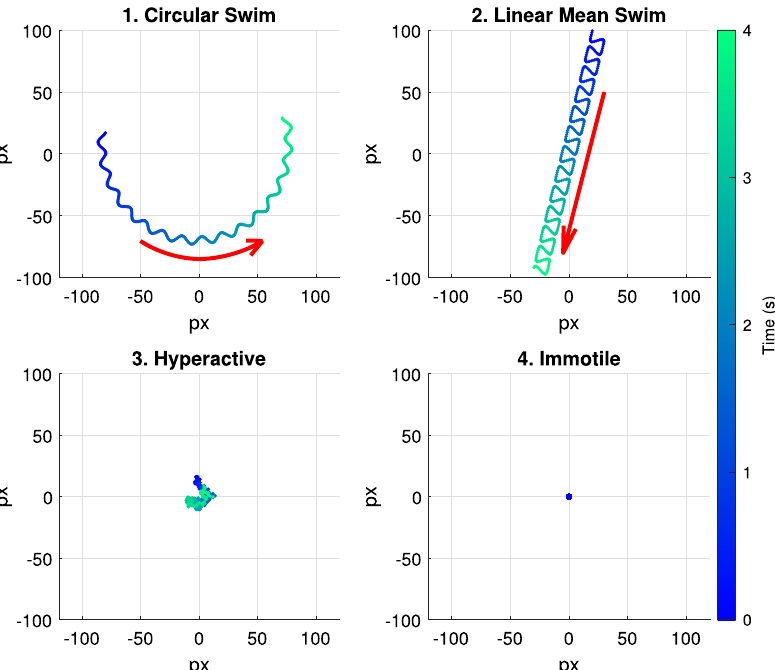
Figure 11. Simulated swimming path of the four swimming modes: circular swim, linear mean swim, hyperactive, and immotile. The color bar indicates the color of a track with respect to time. The duration of movement is 4